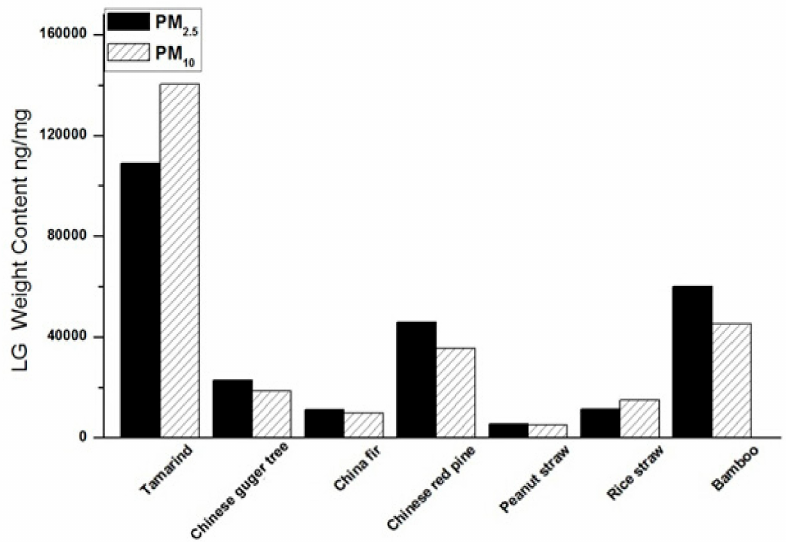
Figure4. LevoglucosanmassratiosinPM 2.5 andPM 10 emittedbycombustionofdi ff